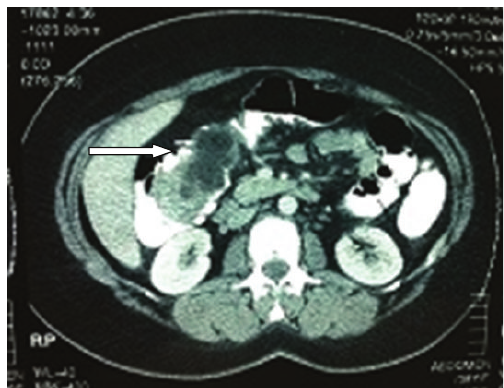
Figure 2: Contrast-enhanced abdominal CT revealing the presence of an ovoid endoluminal mass extending from the cecum to ascending colon with fatty density (arrow) without extramural extension.